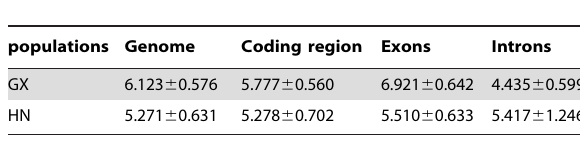
Table 1. Nucleotide diversity ( p ) (mean 6 SD) of csd alleles in Hainan and Guangxi populations.